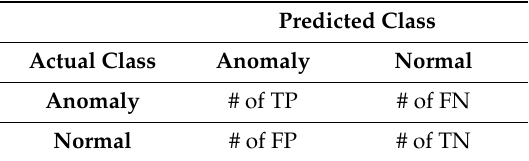
Table A1. Confusion matrix in a binary